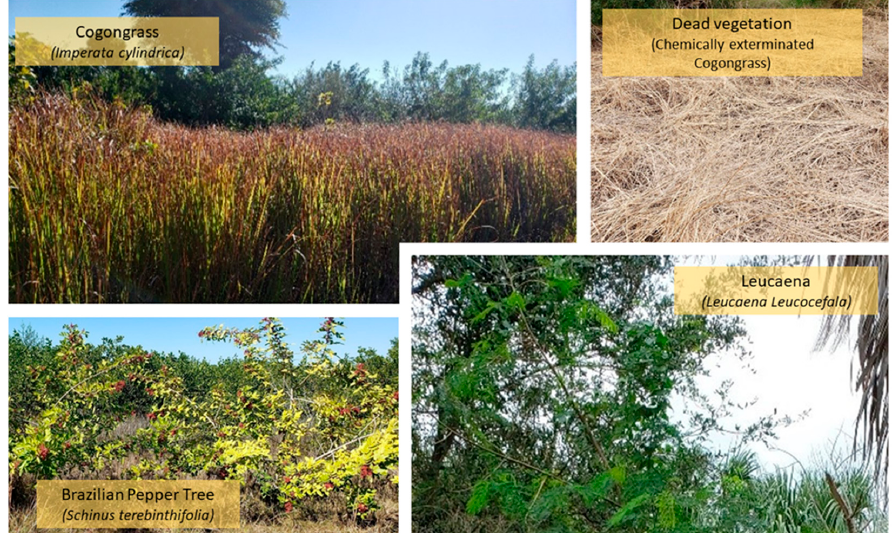
Figure 5. Invasive species present in the Wolf Branch Creek nature reserve. Table 1. Classes defined for the study.